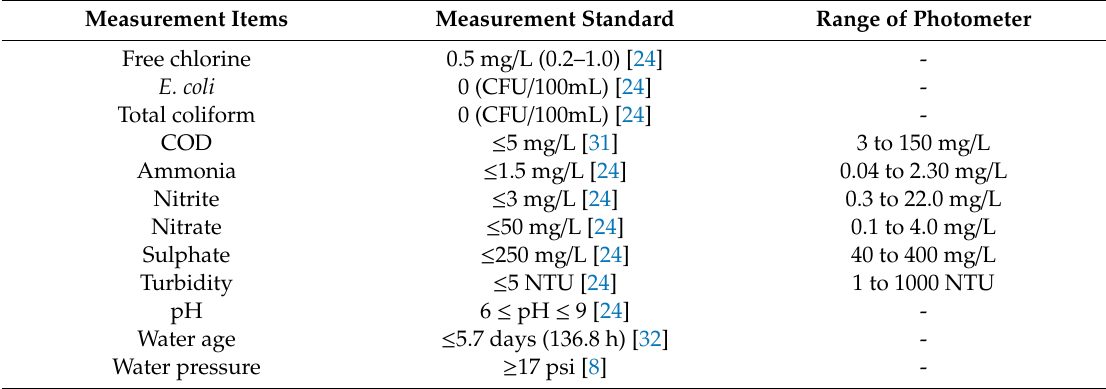
Table 3. Measured parameters of water quality, the standards of water quality and range of photometer used.